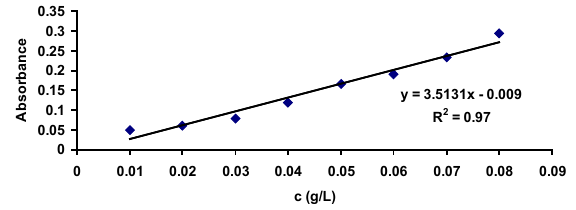
Figure 9: The calibration graph, as absorbance versus sulfite concentration dependence, developed at the photometric assay based on the reduction of Fe 3+ -orthophenanthroline complex.